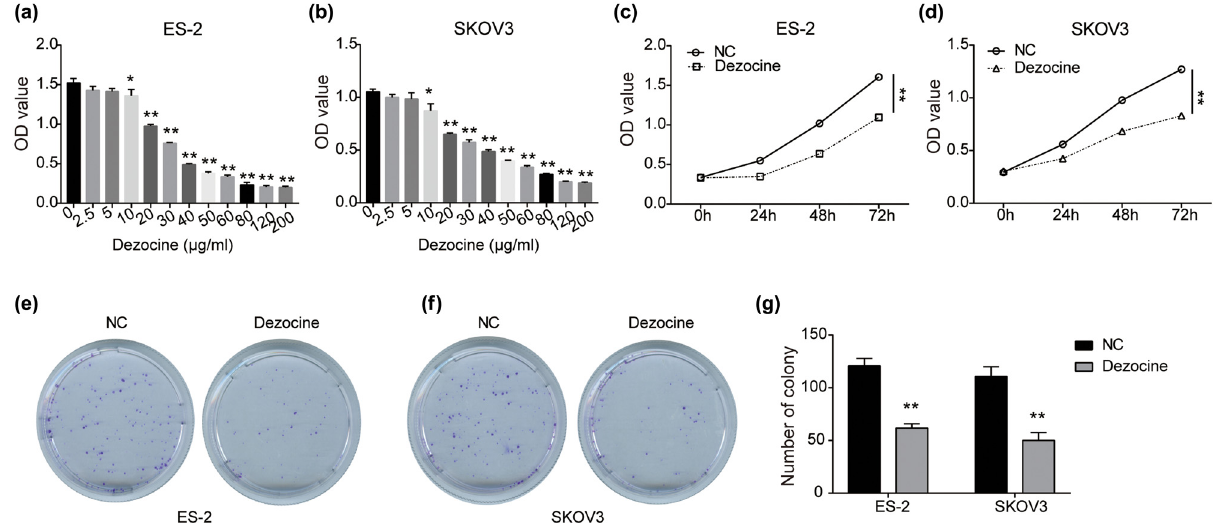
Figure 1: Dezocine inhibits ovarian cancer cell proliferation and colony formation. ( a and b ) ES - 2 ( a ) and SKOV3 ( b ) cells were treated with various concentration levels of dezocine ( 0, 2.5, 5, 10, 20, 30, 40, 50, 60, 80, 120, and 200 μ g/mL ) for 24 h, and cell viability was measured by CCK8 assay. ( c and d ) Cell viability was measured by CCK8 assay in ES - 2 ( c ) and SKOV3 ( d ) cells treated with dezocine for 0, 24, 48, and 72 h, respectively. ( e and f ) Colony formation assay showing inhibitory e ff ects of dezocine on ES - 2 ( e ) and SKOV3 ( f ) cells. ( g ) Quantitative analysis of colony formation results. * P < 0.05, ** P <